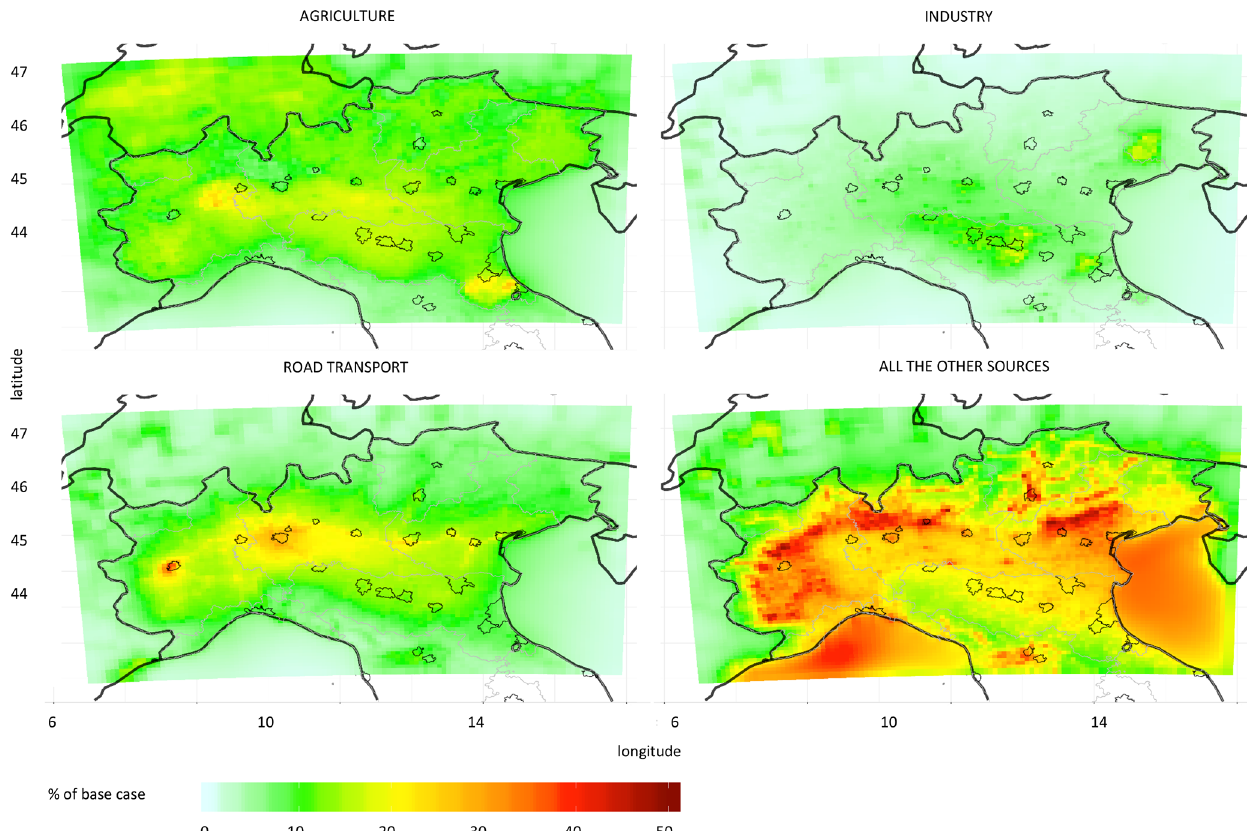
Figure 1. Annual contributions of the PM 10 sources over the Po Valley area according to the tagged species (TS) approach as computed by CAMx-PSAT. The grey lines indicate the boundaries of the regions and the polygons represent the municipal areas of the main cities.